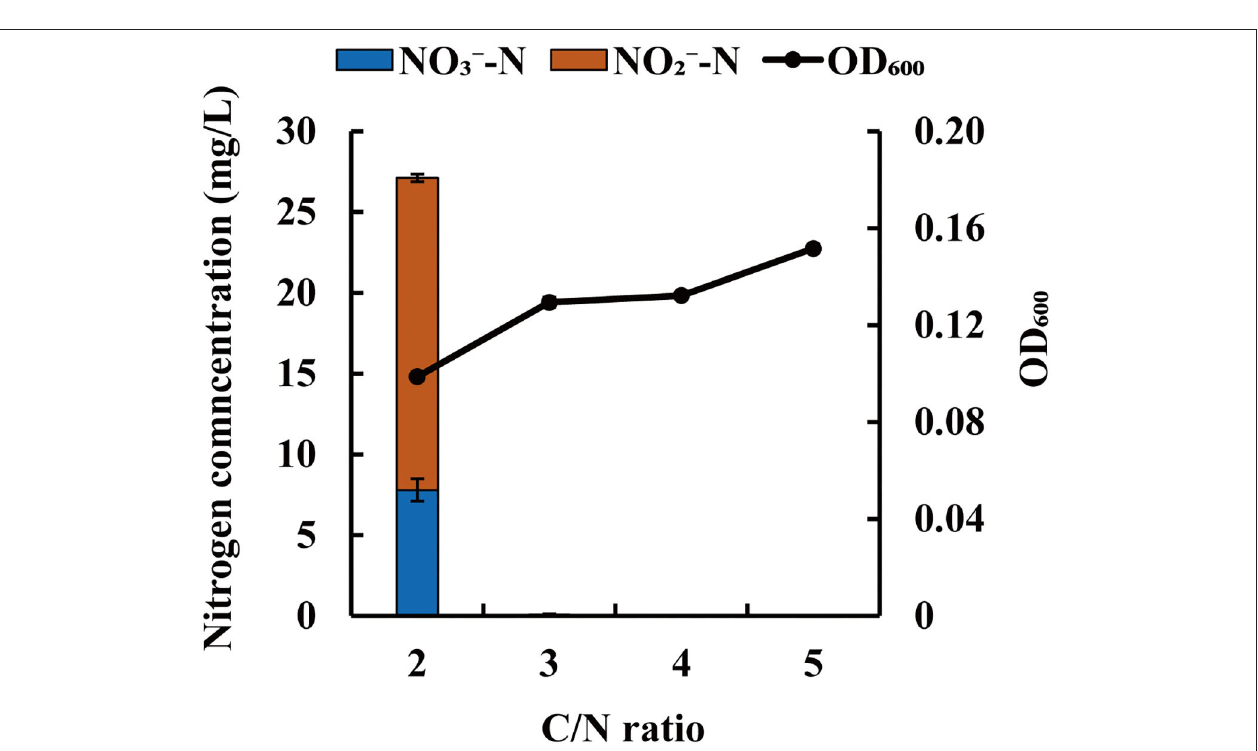
FIGURE 5 | Influence of C/N ratio on NO − 3 -N removal characteristic of strain JM10B5a T . Values are mean ± SE (standard error) for four replicates.